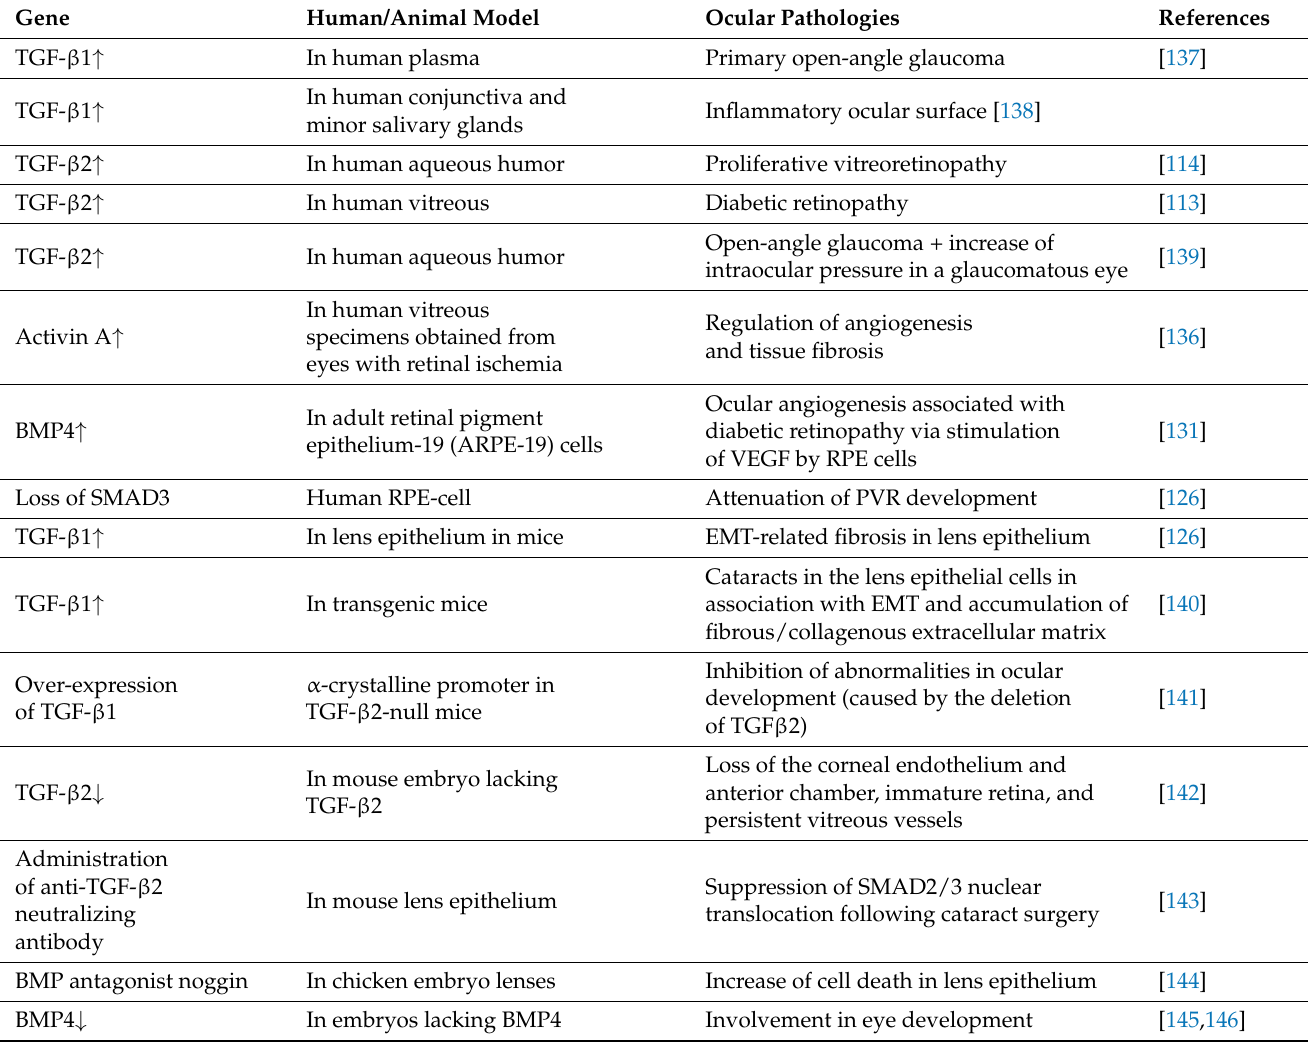
Table 1. TGF- β expression and role in ocular